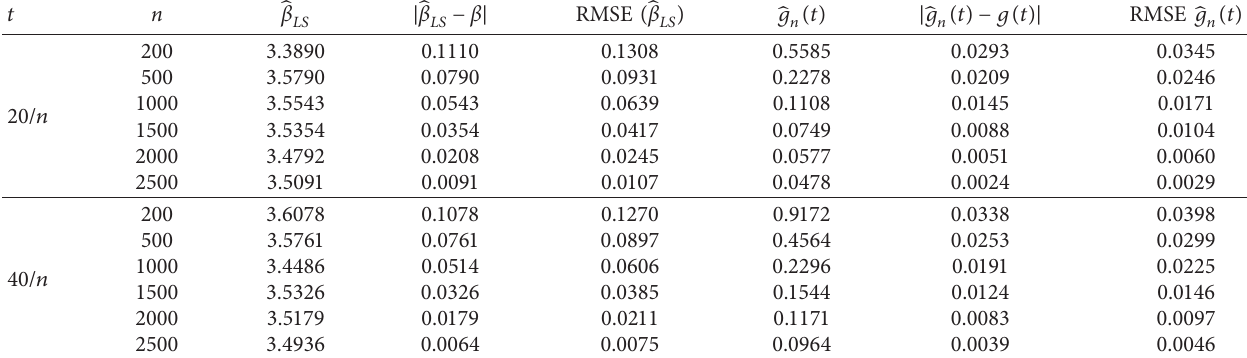
􏽢 g ( t ) with β � 3 . 5 and g ( t ) � sin ( 2 π t ) . n LS and